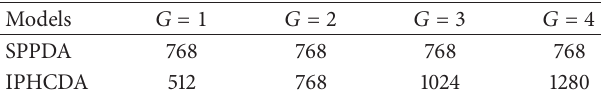
Table 8: The length of ciphertext in two models ( 𝜆 = 256 , unit is